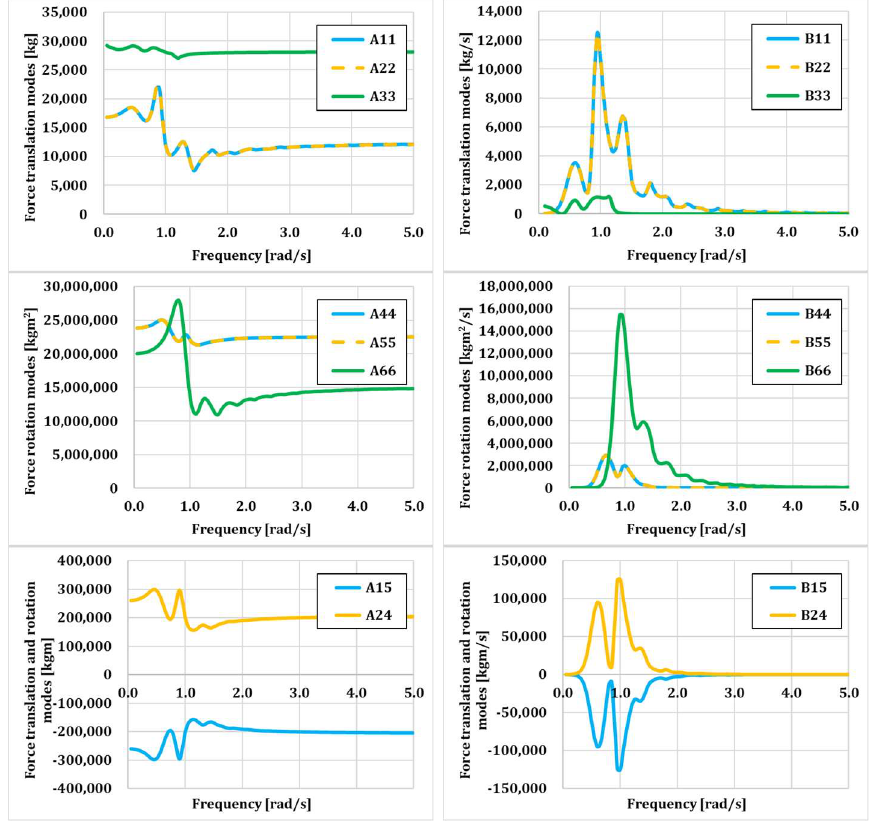
Figure 10. Added mass and damping coefficients.